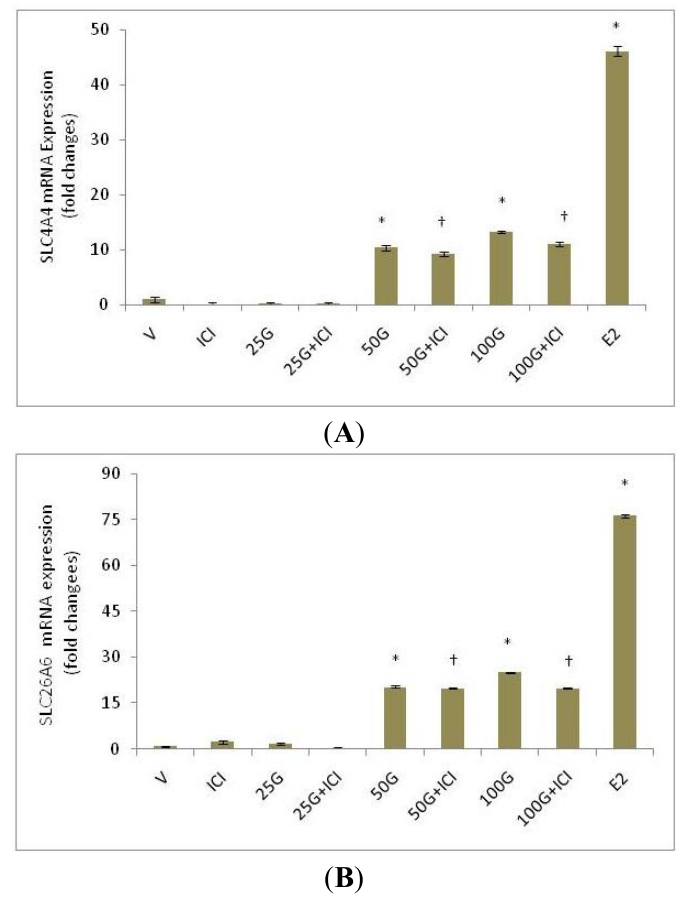
Figure 2. Fold changes in the mRNA expression of ( A ) SLC26A6 and ( B ) SLC4A4 in the whole uterine tissue homogenates from rats treated with various doses of genistein (25, 50 and 100 mg/kg/day). An increase in the mRNA expression was observed with increasing doses of genistein. The maximum expression of both transporters’ mRNA was observed following treatment with 100 mg/kg/day genistein and this was significantly lesser than estrogen treatment. Concomitant administration of ICI 182780 caused a significant decrease in the expression of both transporters’ mRNA. SLC26A6 mRNA expression exceed SLC4A4. V: vehicle (peanut oil); ICI: ICI 182780; 25G: 25 mg/kg/day genistein; 50G: 50 mg/kg/day genistein; 100G: 100 mg/kg/day genistein; E2;